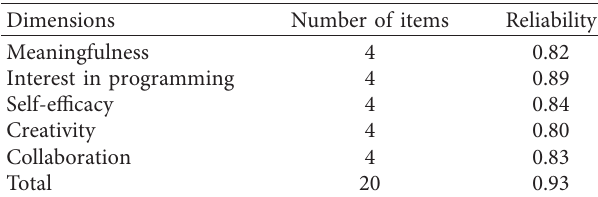
Table 2: Cronbach’s α value of each dimension.